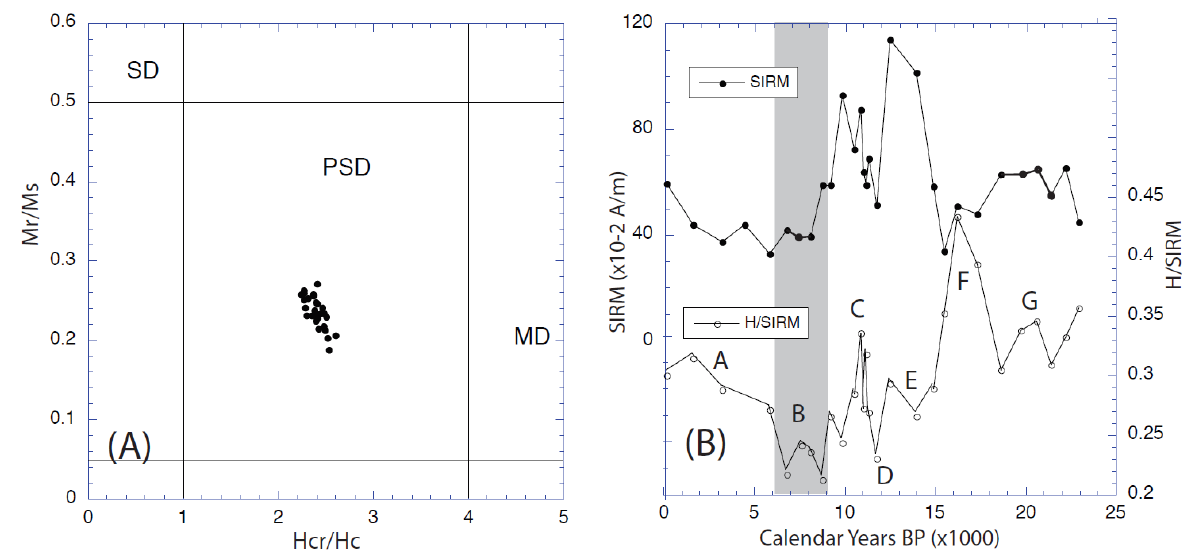
Figure 11. Magnetic hysteresis measurements of selected sediment horizons in core 25GGC. ( A ) Plot of remanent magnetization (Mr)/saturation magnetization (Ms) versus coercivity of remanence (Hcr)/coercivity (Hc). All samples fall within the pseudo-single domain (PSD) range. ( B ) Saturation isothermal remanence (SIRM) and field (H)/SIRM plotted versus time in 25GGC. See text for further discussion.